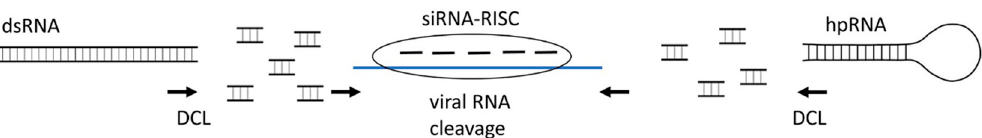
Figure 1. The RNAi antiviral pathway is induced by dsRNA or hpRNA. dsRNA and hpRNA are recognized by plant DCL proteins which then cleave them into siRNAs. siRNAs are subsequently incorporated into the RISC, which guides sequence-specific degradation of viral RNAs or mRNAs encoding virus susceptibility proteins. dsRNA or hpRNAs can be expressed transgenically (HIGS) or applied exogenously (SIGS). Table 1. Foliar application of exogenous dsRNAs for engineering plant virus resistance.